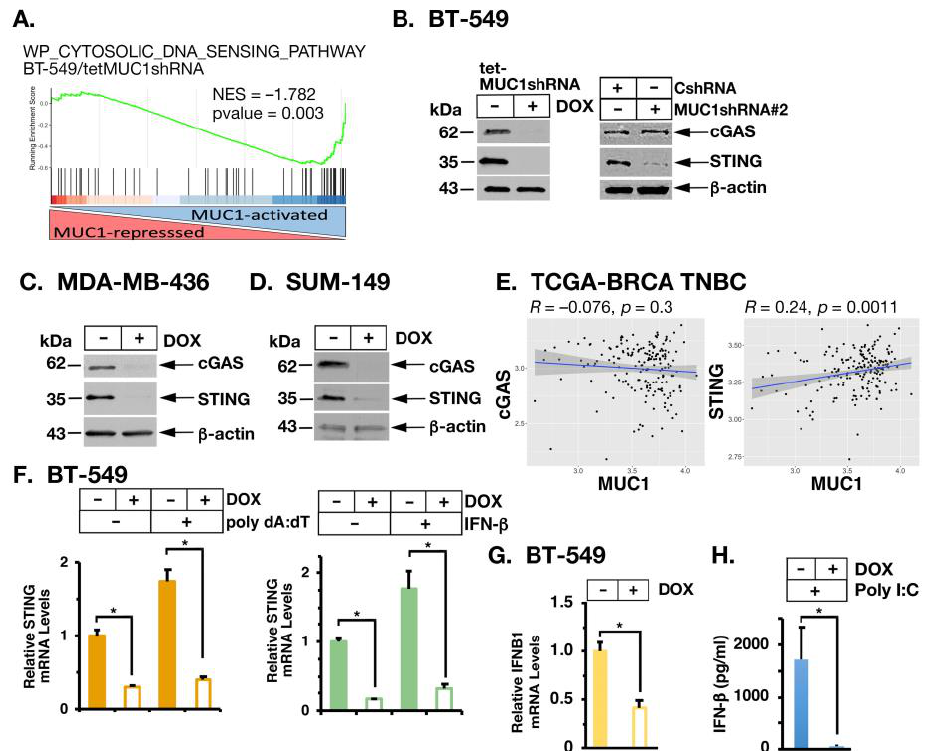
Figure 3. MUC1-C induces cGAS and STING expression. ( A ) Candidate enrichment plot of BT-549 RNA-seq data for the WP CYTOSOLIC DNA SENSING PATHWAY gene signature. ( B ) Lysates from (i) BT-549/tet-MUC1shRNA cells treated with vehicle or DOX for 7 days ( left ) and (ii) BT-549/CshRNA and BT-549/MUC1shRNA#2 cells ( right ) were immunoblotted with antibodies against the indicated proteins. ( C , D ) Lysates from MDA-MB-436/tet-MUC1shRNA ( C ) and SUM149/tet-MUC1shRNA ( D ) cells treated with vehicle or DOX for 7 days were immunoblotted with antibodies against the indicated proteins. ( E ) Scatter plots showing correlations of MUC1 with cGAS and STING in TNBCs from the TCGA-BRCA cohort. ( F ) BT-549/tet-MUC1shRNA cells treated with vehicle or DOX for 7 days and transfected with poly dA:dT for 12 h ( left ) or stimulated with IFN- β for 24 h ( right ) were analyzed for STING mRNA levels by qRT-PCR. ( G ) BT-549/tet-MUC1shRNA cells treated with vehicle or DOX for 7 days were analyzed for IFNB1 mRNA levels by qRT-PCR. The results (meanSD of 4 determinations) are expressed as relative mRNA levels compared to that obtained for vehicle-treated cells (assigned a value of 1). ( H ) BT-549/tet-MUC1shRNA cells were treated with vehicle or DOX for 7 days and then transfected with poly I:C for 12 h. Supernatants were analyzed for IFN- β levels by ELISA. The results (mean ± SD of 3 determinations) are expressed as IFN- β pg/mL. The asterisk (*) denotes a p -value < 0.05. Uncropped Western Blots can be found at supplemental original images.